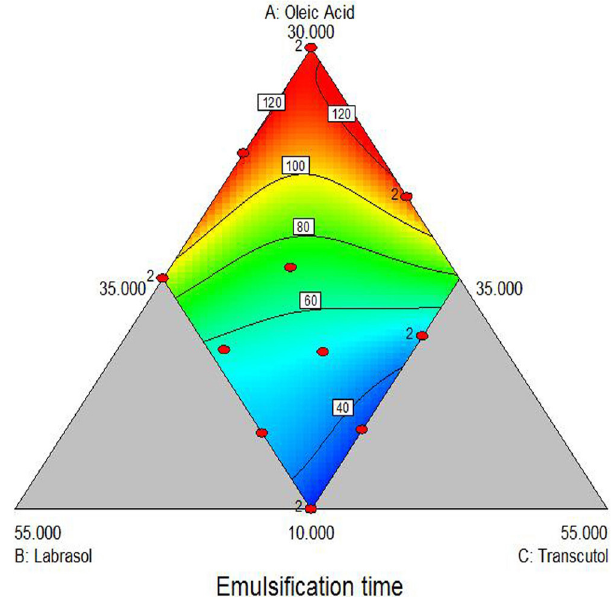
versus three factors (X Transcutol